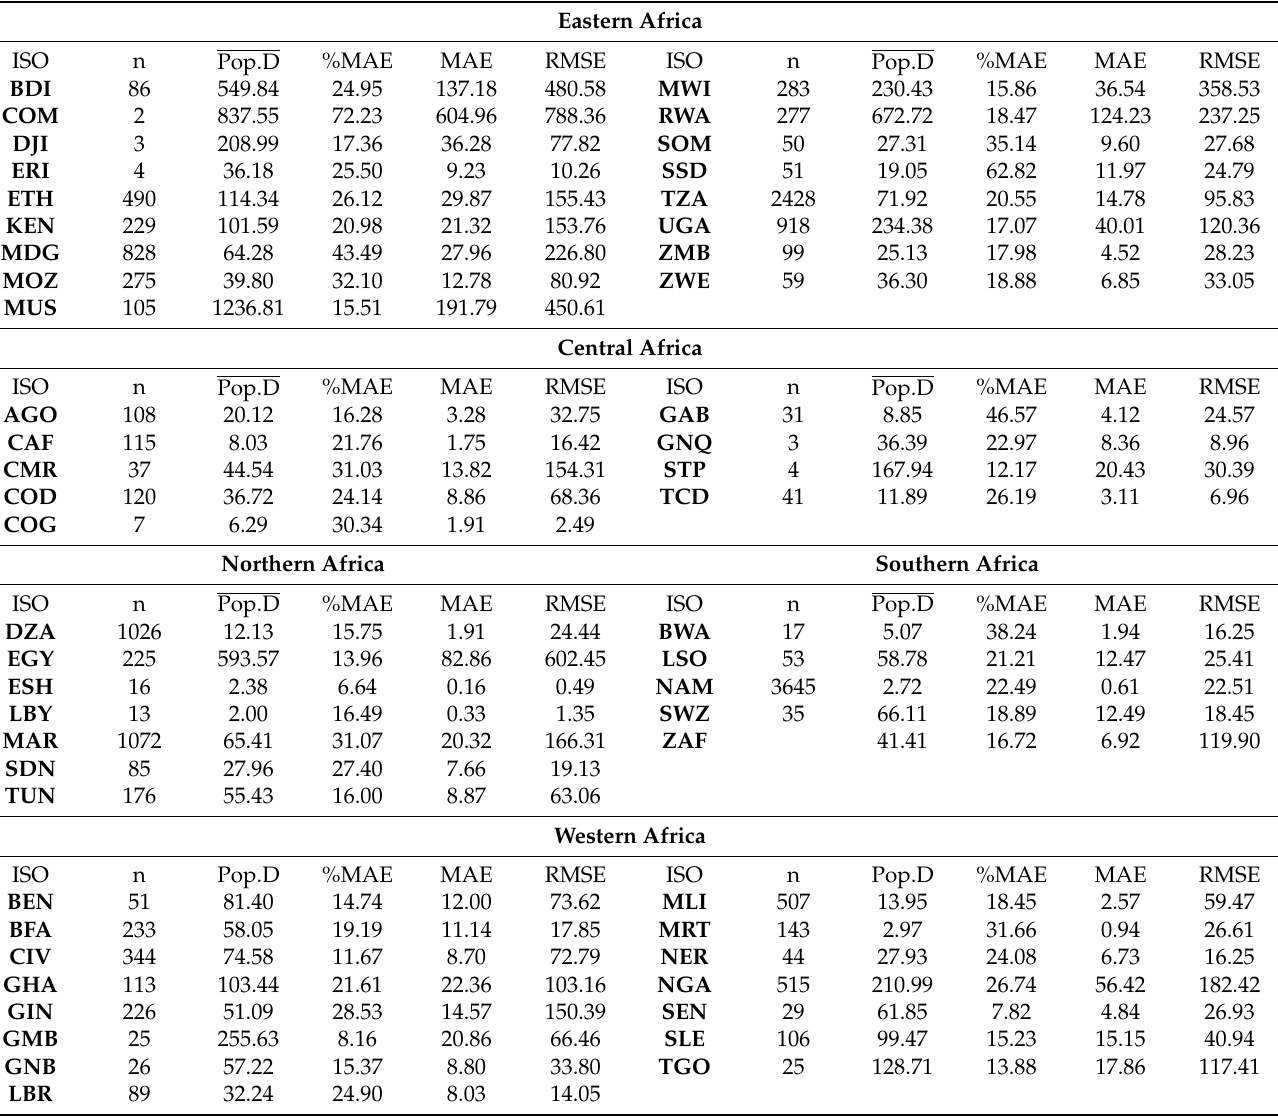
Table 3. Statistical metrics for population